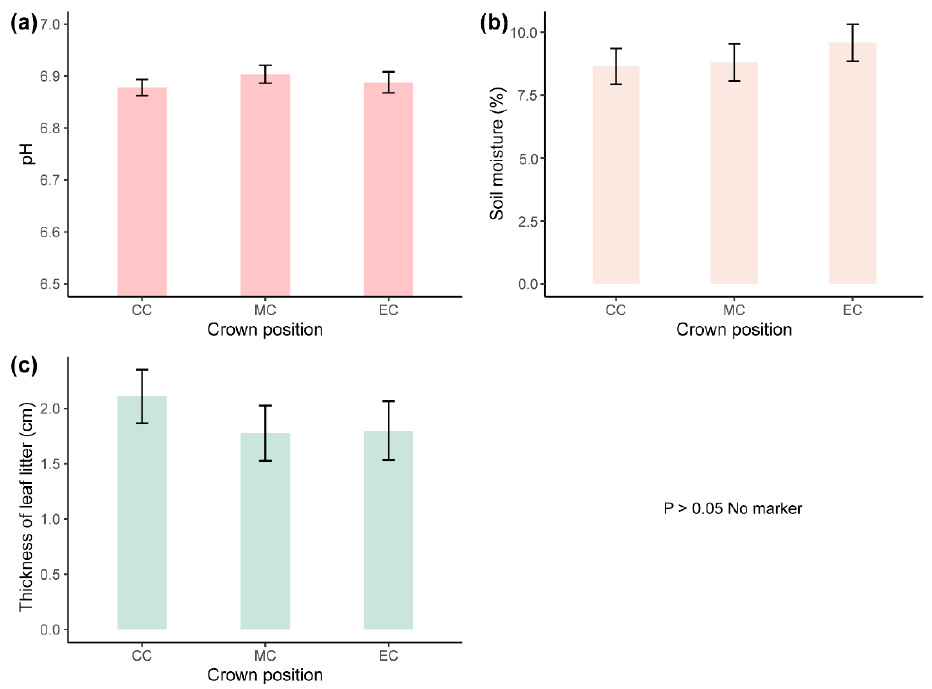
Figure 4. The environmental characteristics (mean ± SE) at the three crown positions (CC—the center of the crown, MC—the middle of the crown, EC—the edge of the crown) [( a ) The soil pH at the three crown positions; ( b ) The soil moisture at the three crown positions; ( c ) The thickness of leaf litter at the three crown positions].